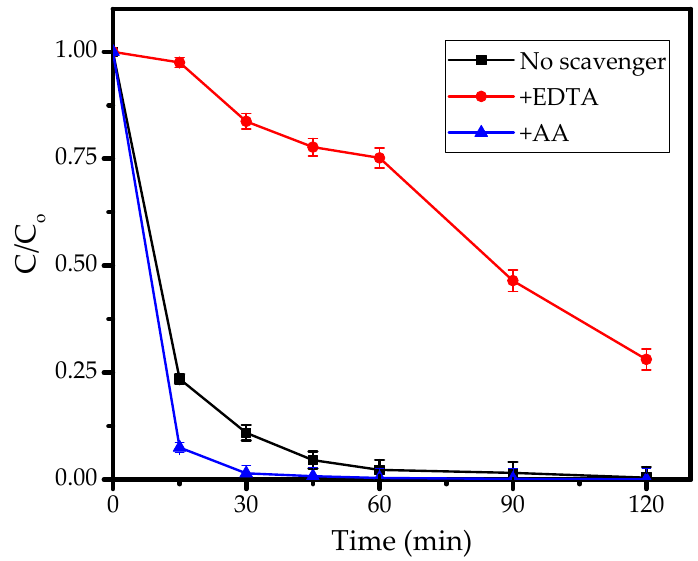
Figure 12. Kinetics of MV photodegradation in the presence and absence of